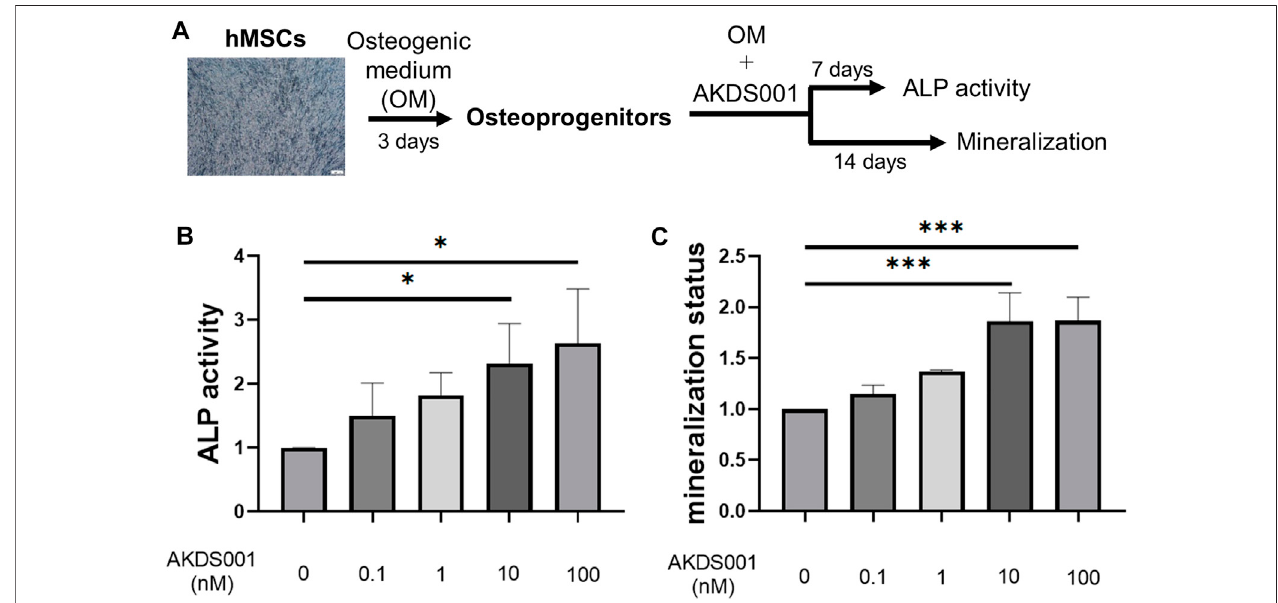
FIGURE 7 | Effect of AKDS001 on human mesenchymal stem cells (hMSCs). (A) Scheme showing the protocol of osteoblastic differentiation. (B) ALP activity of hMSCs treated with osteogenic medium (OM) and AKDS001 (0 – 100 nM). ALP activity in the treatment group was expressed relative to that of the control group (AKDS001 0 nM). n = 3 per group. (C) Mineral apposition of hMSCs with OM and AKDS001 (0 – 100 nM). Mineral apposition in the treatment group was expressed relative to that of the control group (AKDS001 0 nM). n = 3 per group. * p < 0.05, *** p < 0.001 by Dunnett ’ s